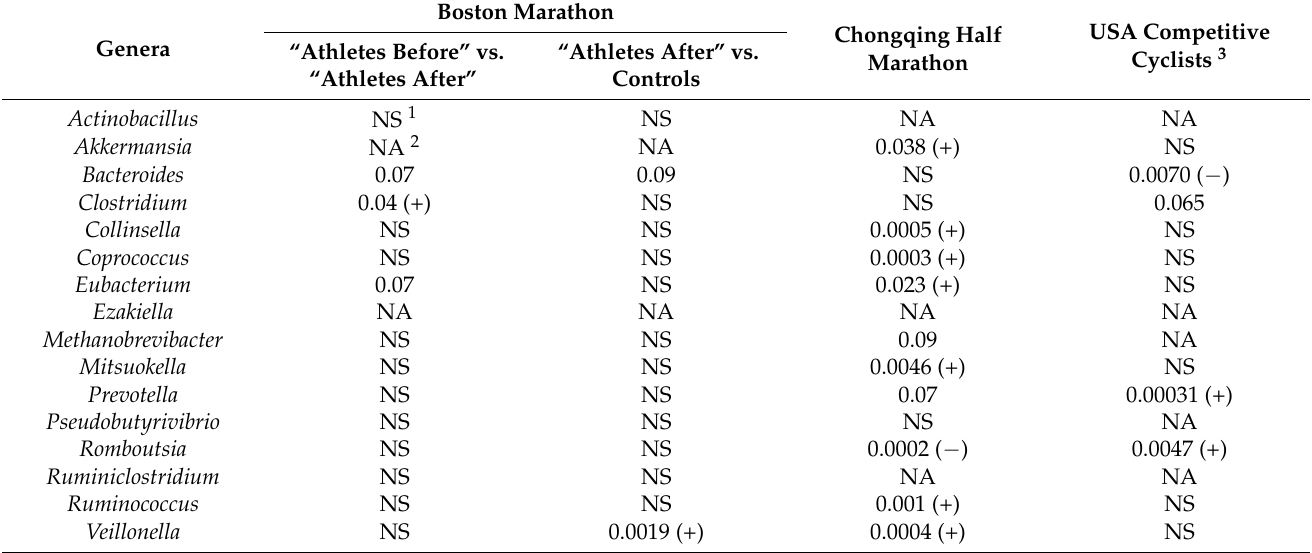
Table 3. Relative abundance statistical results. p -values from Wilcoxon rank sum tests with continuity correction for the relative abundance comparisons among 16 target genera across the four treatment group comparisons. No correction for multiple testing was applied to the target genera since these target genera were predicted to be significant a priori. A plus sign (+) following the p -values indicates that the abundance in the endurance treatment group was greater than the control group. A minus sign ( − ) indicates that the abundance in the endurance group was less than the control group. Boston Marathon USA Competitive Chongqing Half Genera “Athletes After” vs. Cyclists 3 “Athletes Before” vs. Marathon “Athletes After”